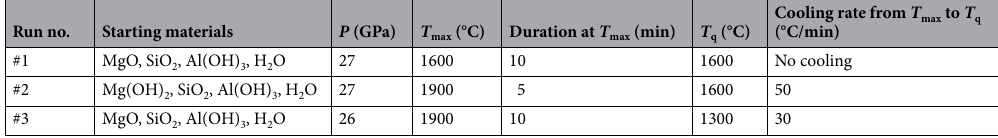
Run no. Starting materials